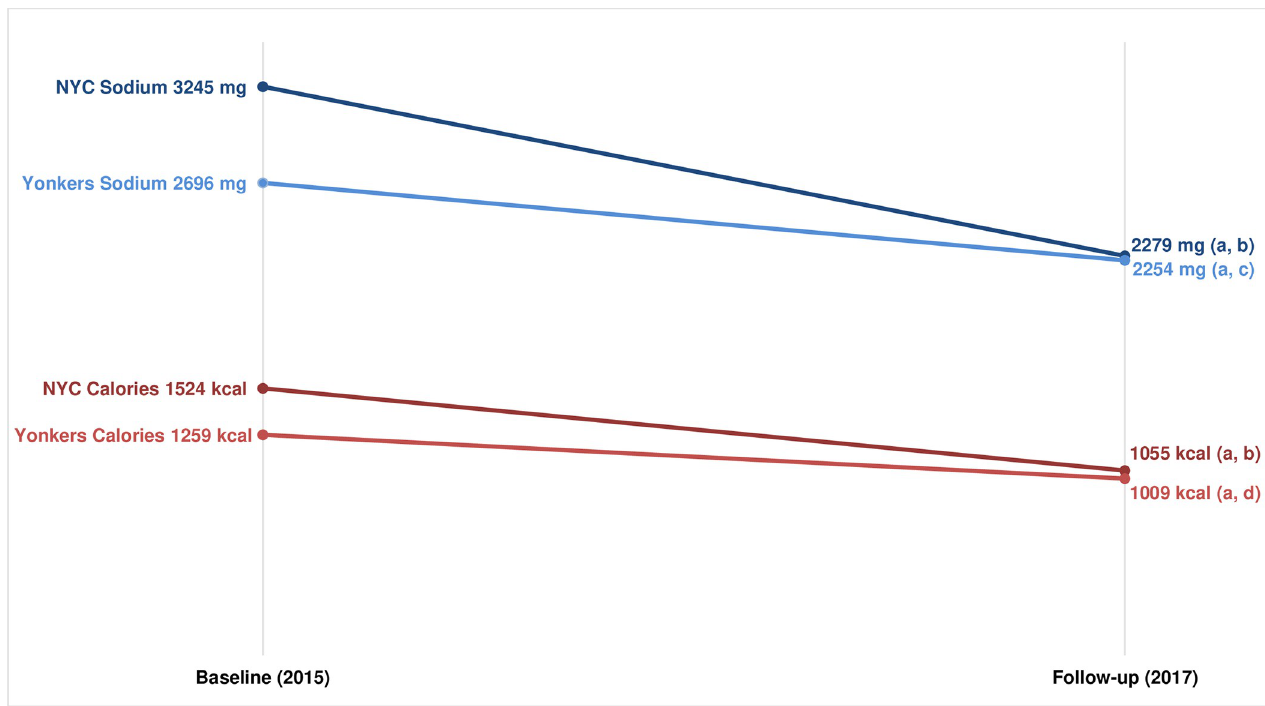
Fig 3. Mean sodium and calorie content * of dinnertime purchases at FSR chains, pre- (Baseline) and post- (Follow-up) implementation of the sodium warning icon in NYC. Baseline data were collected between October 2015-January 2016. Follow-up data were collected between April-June 2017. * Sodium and calorie values were square-root-transformed during analysis to meet model normality assumptions and to estimate differences (p values), but least-squared means estimates from models using non-transformed variables are presented for ease of interpretation. Full model estimates are shown in S5 Table in S1 File. a) NYC vs Yonkers Difference-in-Difference p value < 0.05; b) 2015–16 vs 2017 p value < 0.001; c) 2015–16 vs 2017 p value < 0.05; d) 2015–16 vs 2017 p value < 0.01.